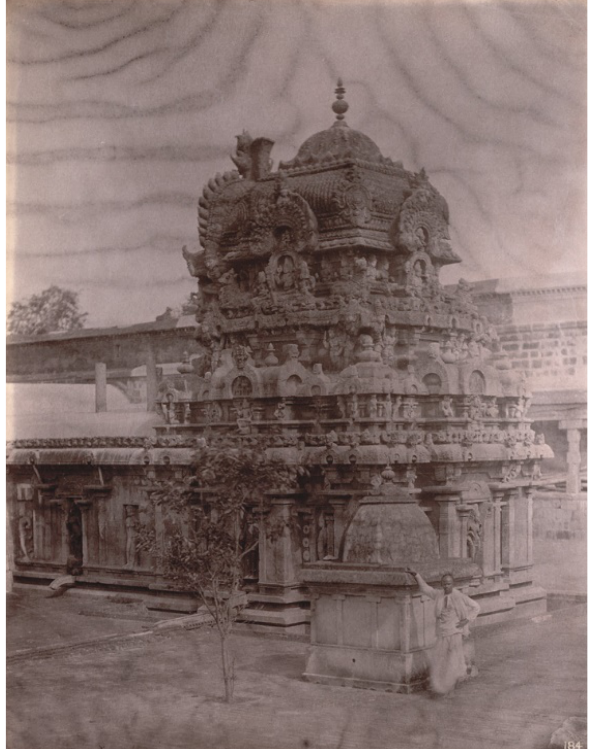
Figure 4. View from the north-west corner of the shrine of the